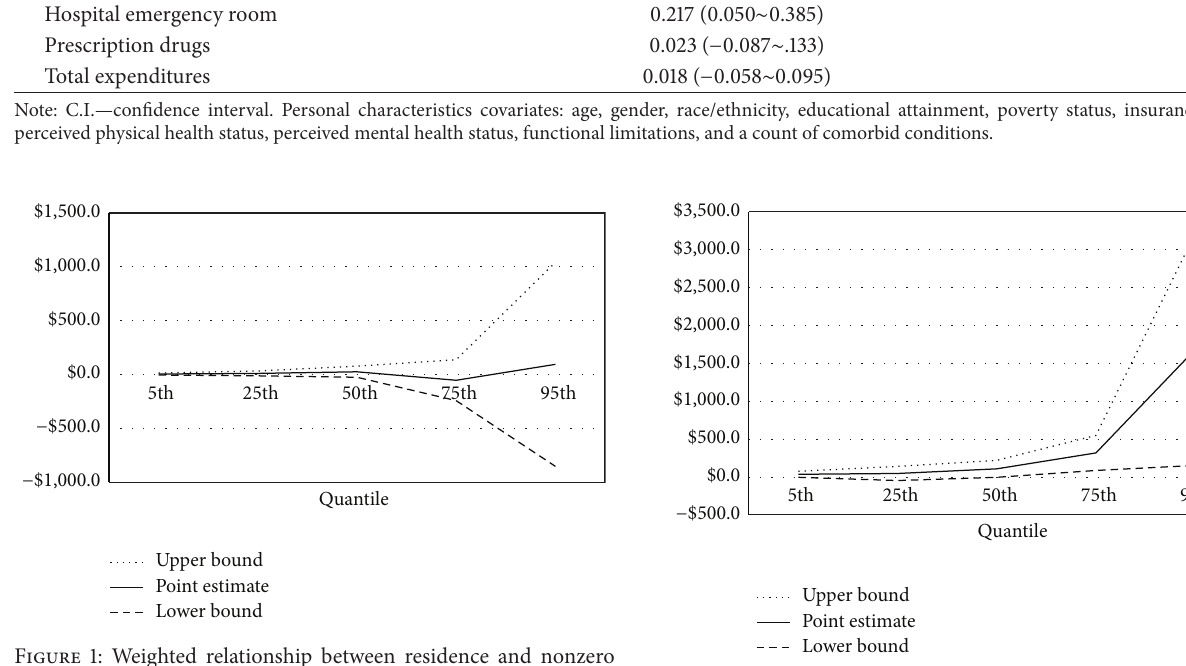
Figure 3: Weighted relationships between residence and nonzero expenditure of hospital emergency room service, adjusted by 10